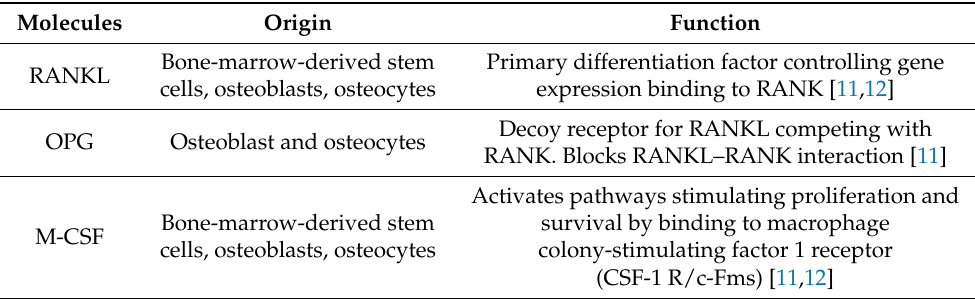
Table 1. Summary of osteoclastogenesis molecules, origin, and functions. Molecules essential for osteoclastogenesis include: receptor activator of nuclear factor (NF)-kB ligand (RANKL), osteoprote- gerin (OSP), macrophage-colony stimulating factor